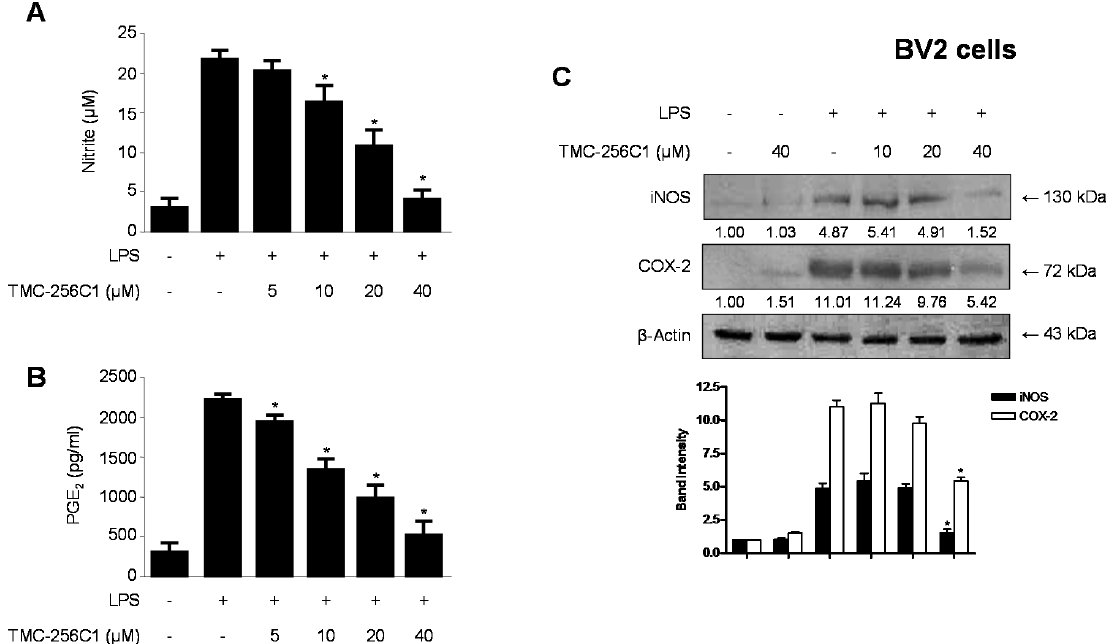
Figure 4. Effects of TMC-256C1 on the production of NO ( A ) and PGE 2 ( B ) and the protein expression levels of inducible nitric oxide synthase (iNOS) and cyclooxygenase-2 (COX-2) ( C ) in BV2 cells stimulated with LPS. Cells were pre-treated for 3 h with the indicated concentrations of TMC-256C1, and for 24 h with LPS (1 µ g/mL). Western blot analysis ( C ) was performed as described in the Experimental Section. Band intensity was quantified by densitometry and normalized to β -actin, and the normalized values are presented at the bottom of each band. Data represent the mean values of three experiments ± SD. * p < 0.05 compared to the group treated with LPS.